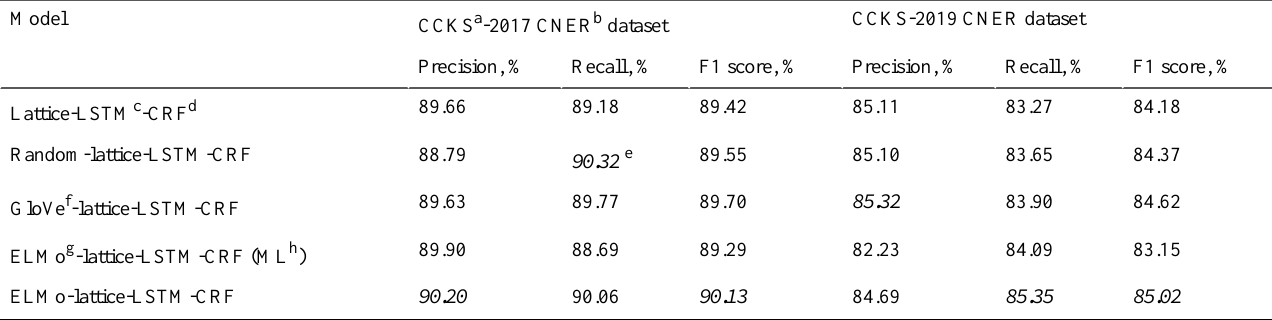
Table 7. Comparison of different types of character embedding added to the lattice long short-term memory (LSTM) model using two clinical named entity recognition (CNER)